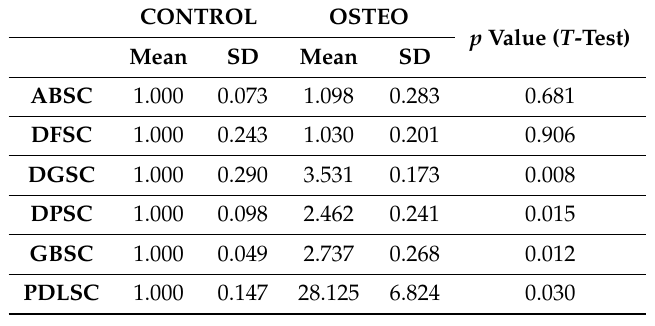
Table 4. Normalized expression of SPARC after 28 days in osteogenic induction media.